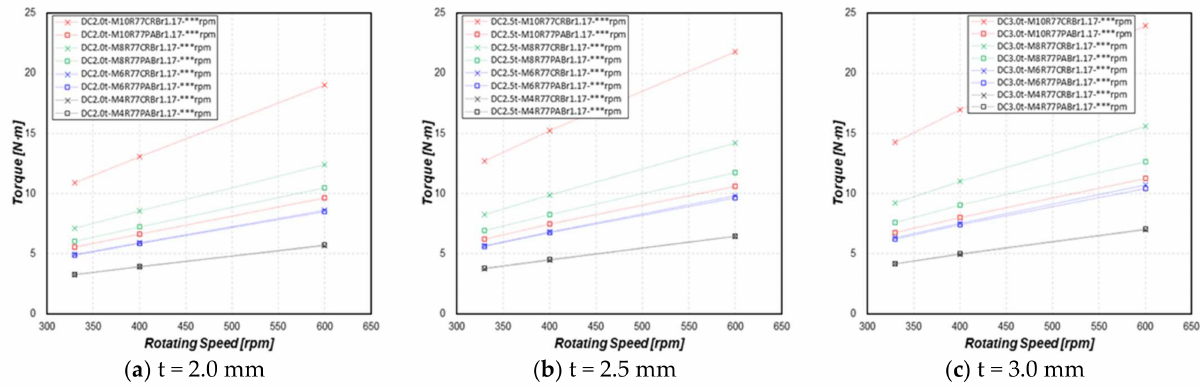
Figure 5. Torque vs. rotational speed plot.